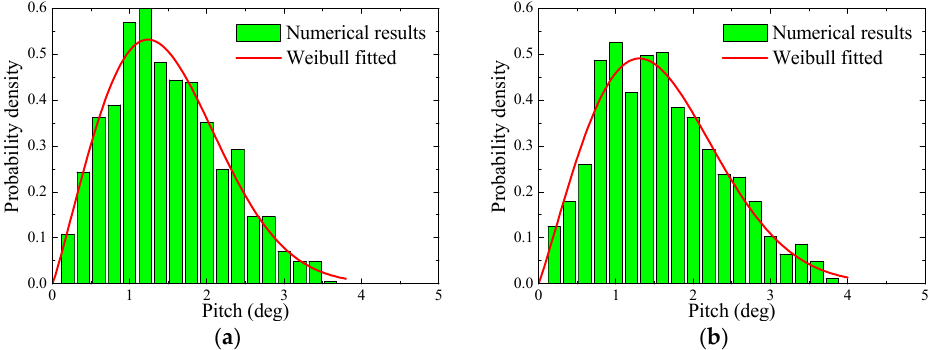
Figure 16. The histogram of pitch peak distribution. ( a ) Nonlinear pitch crest; ( b ) nonlinear pitch trough.